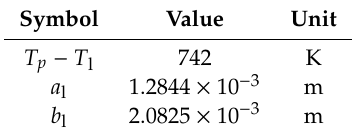
Table 4. The characteristic parameters of the molten pool.